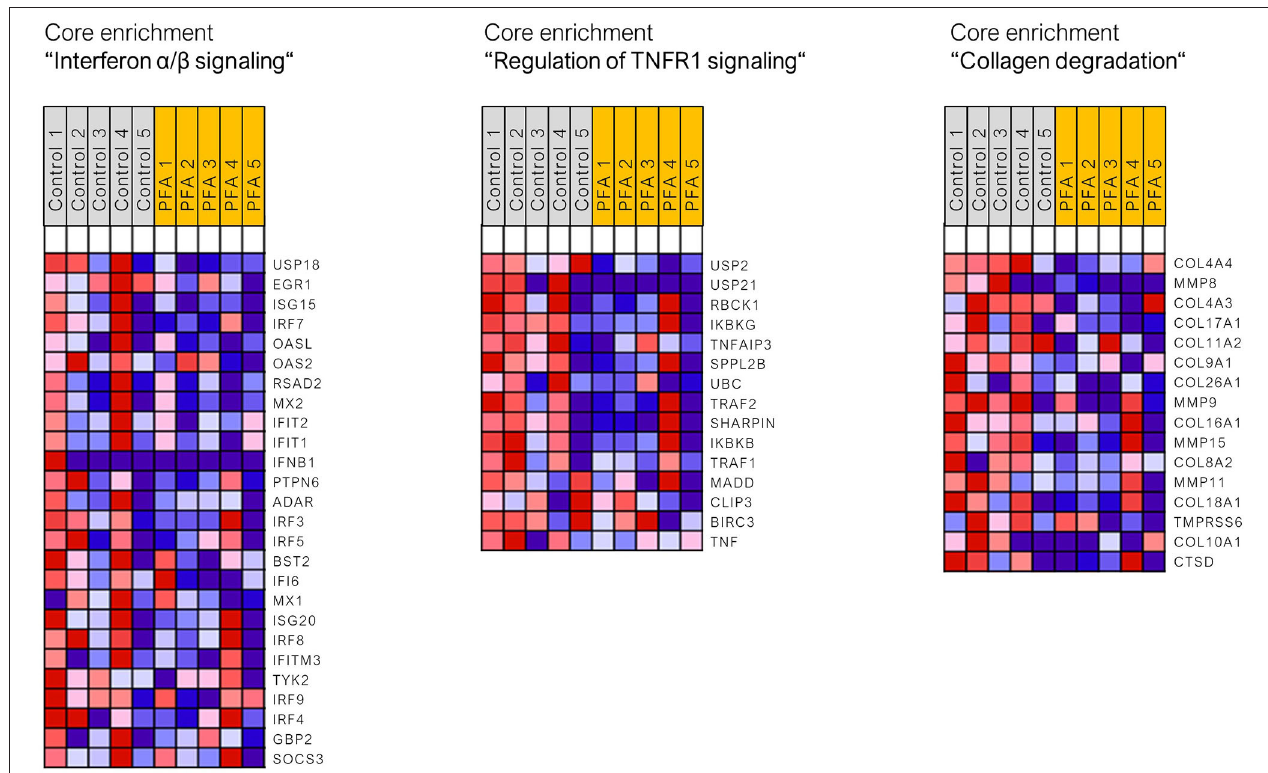
FIGURE 1 | Heat map of the genes found in the core enrichment for the respective signaling pathways. Expression values are represented as colors, where the range of colors (red, pink, light blue, and dark blue) shows the range of expression values (high, moderate, low, and